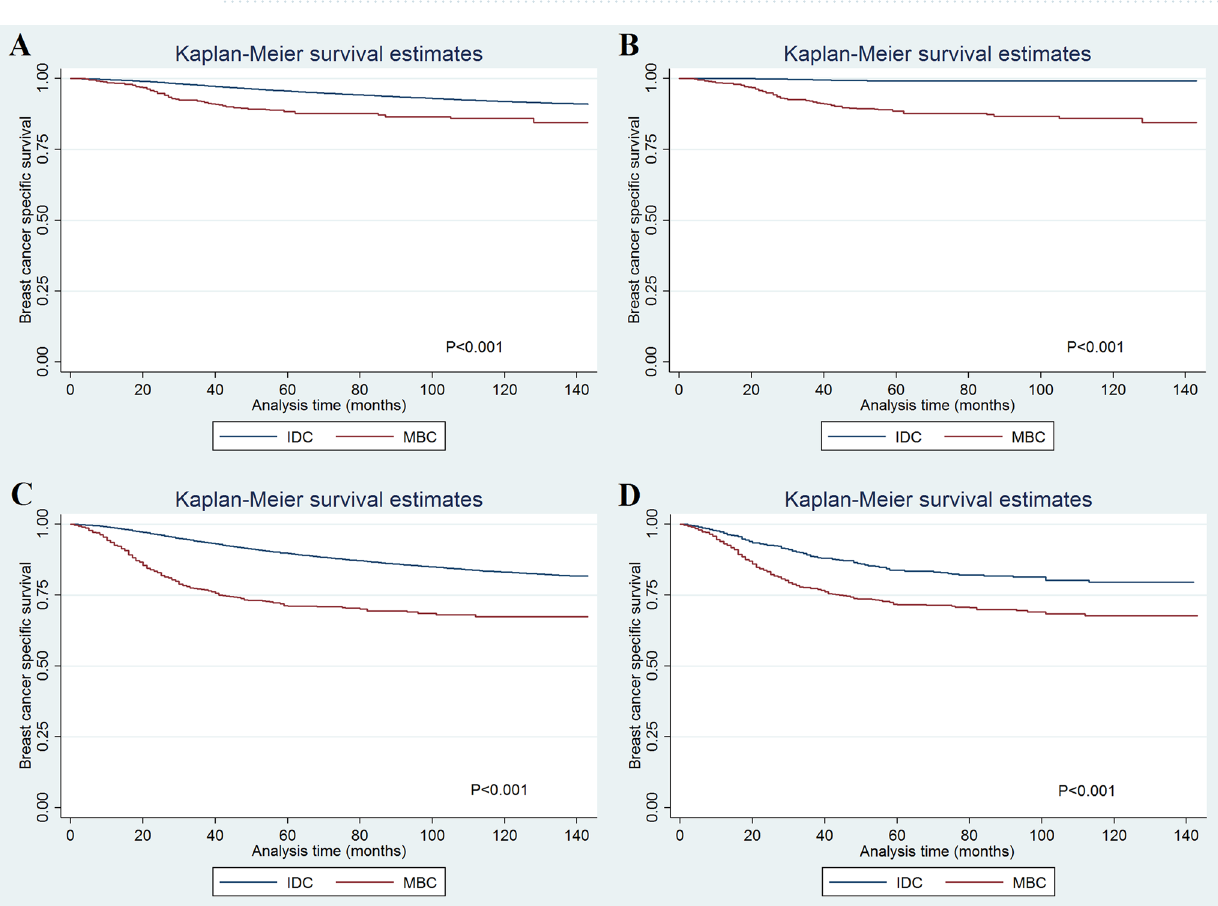
Figure 2. The breast cancer-specific survival between invasive ductal carcinoma and metaplastic breast carcinoma before [breast conserving surgery cohort: ( A ); mastectomy cohort: ( C ) and after (breast conserving surgery cohort: ( B ); mastectomy cohort: ( D )] propensity score matching according to surgical